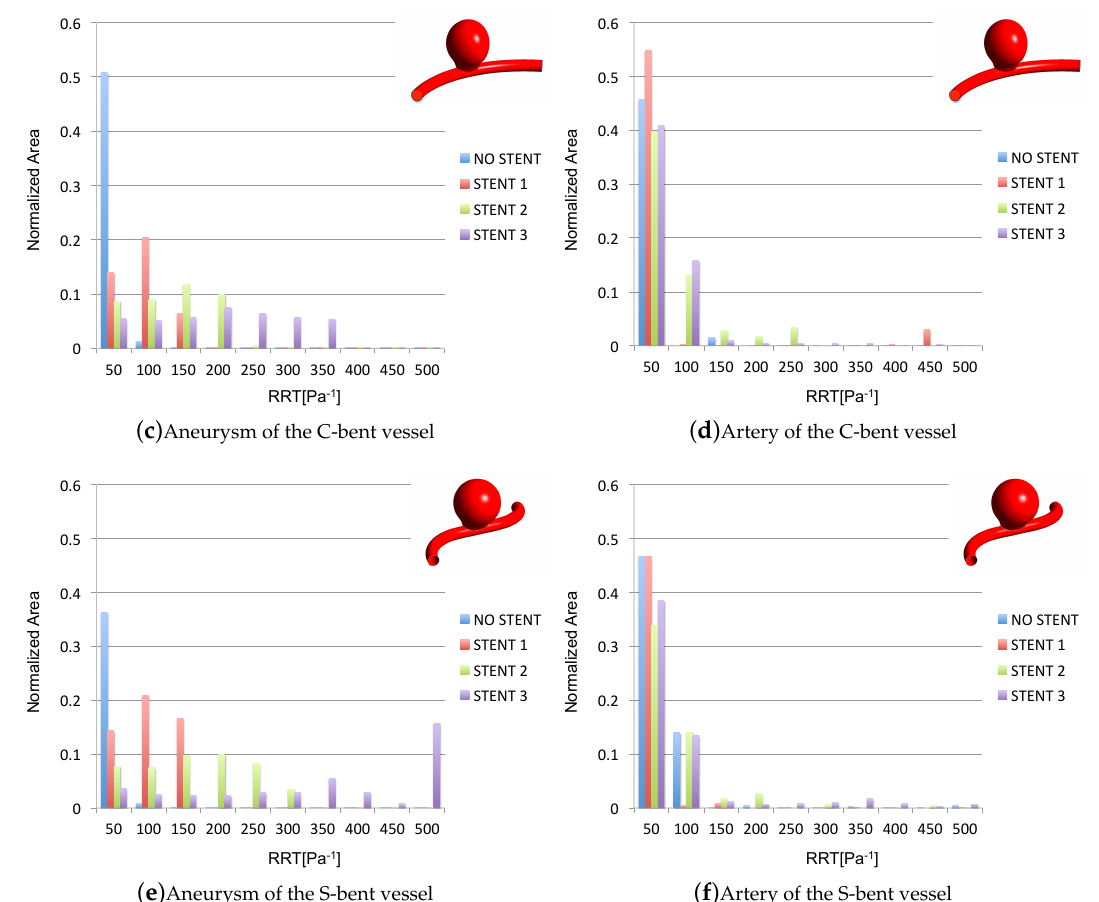
Figure 10. Histograms of the normalized area associated to the OSI of the aneurysm and of the artery (and stent) for V-bent, C-bent and S-bent vessel configurations. The depicted areas are normalized with respect to the area of whole geometry